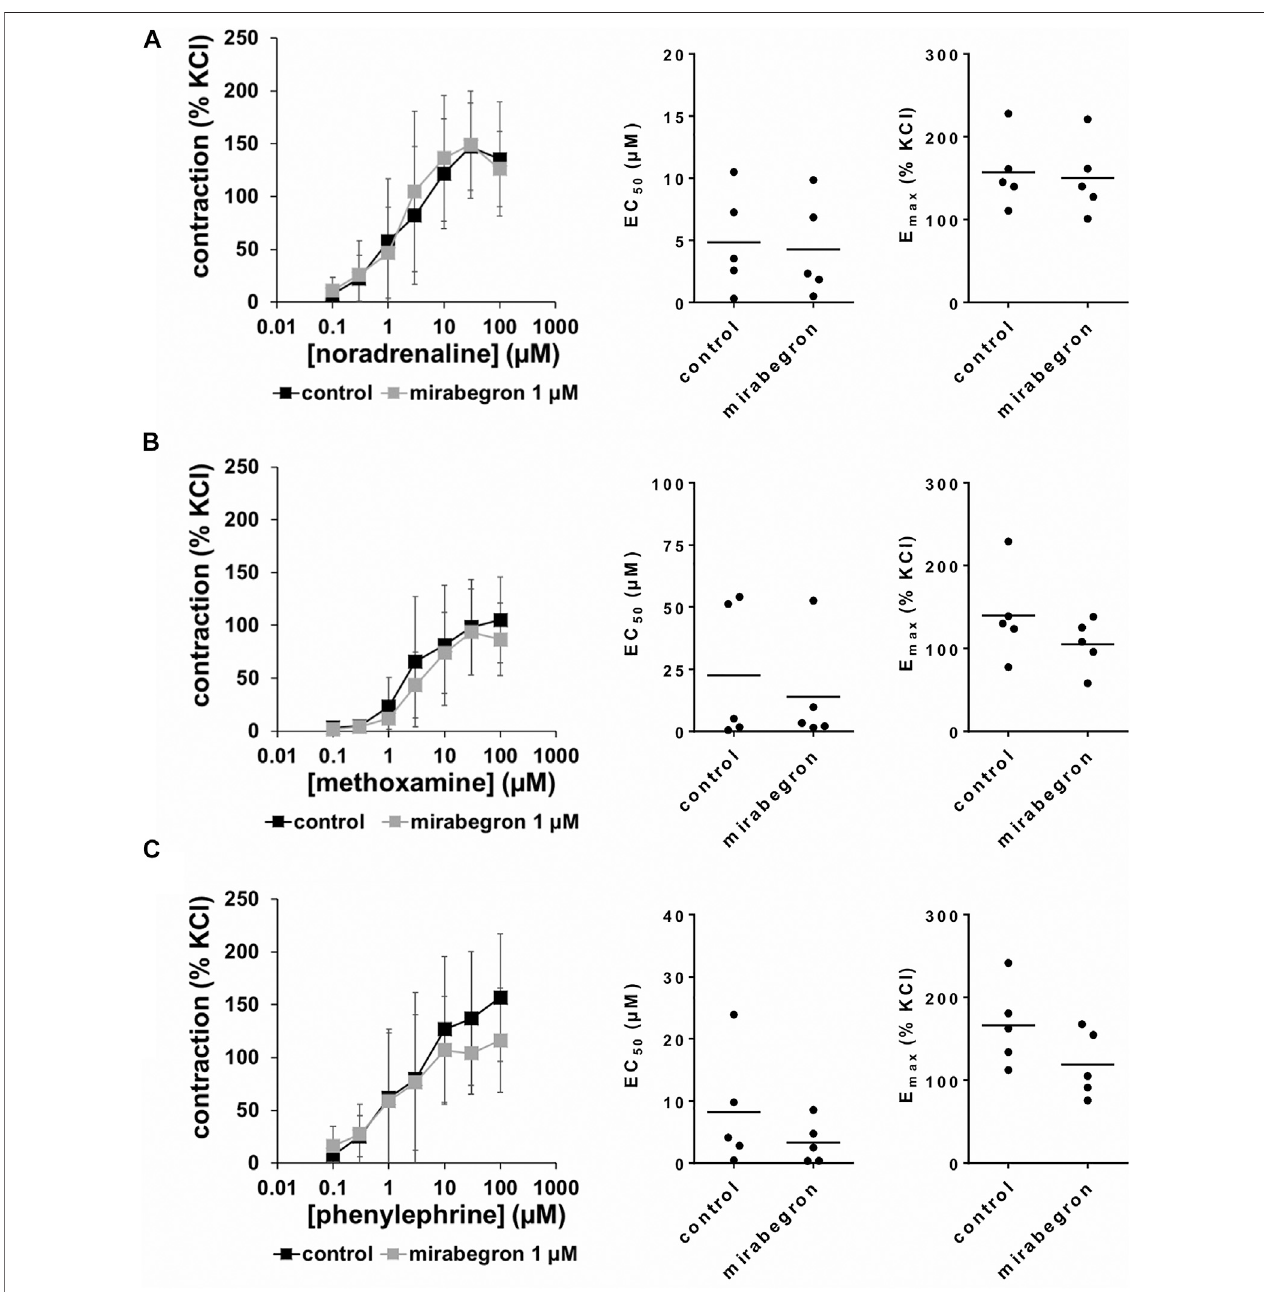
FIGURE4 | Effects of1 µM mirabegron on α 1 -adrenergic contractionsof human prostate tissues. Contractionsofprostate tissuesfrom the periurethral zone were inducedbycumulativeconcentrationsofnoradrenaline (A) ,methoxamine (B) orphenylephrine (C) inanorgan bath, 30 minafter addition ofmirabegron oranequivalent amount of DMSO (controls), which was used as solvent for mirabegron. Shown are data from n (cid:1) 5 patients in each diagram, which are means ± SD in frequency response curves, and E max and EC 50 values for single experiments (calculated by curve fi tting) in scatter